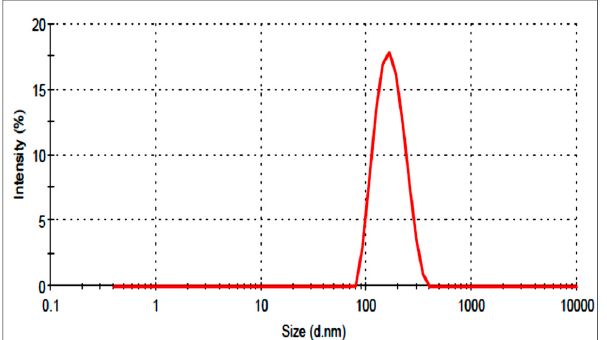
Figure 4. Particle size distribution image of Azithromycin-loaded nano lipid carrier (AM-NLop).